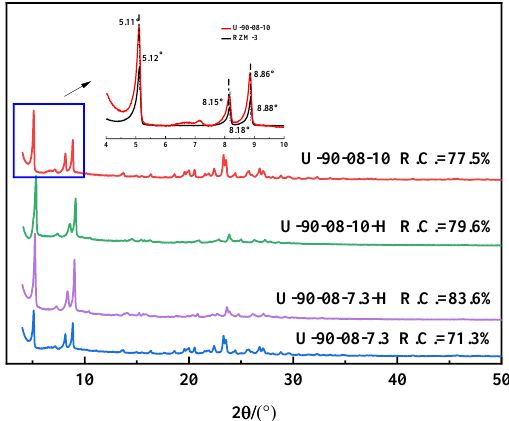
Figure 5. The XRD pattern of samples with n (SiO 2 )/ n (B 2 O 3 ) = 90.